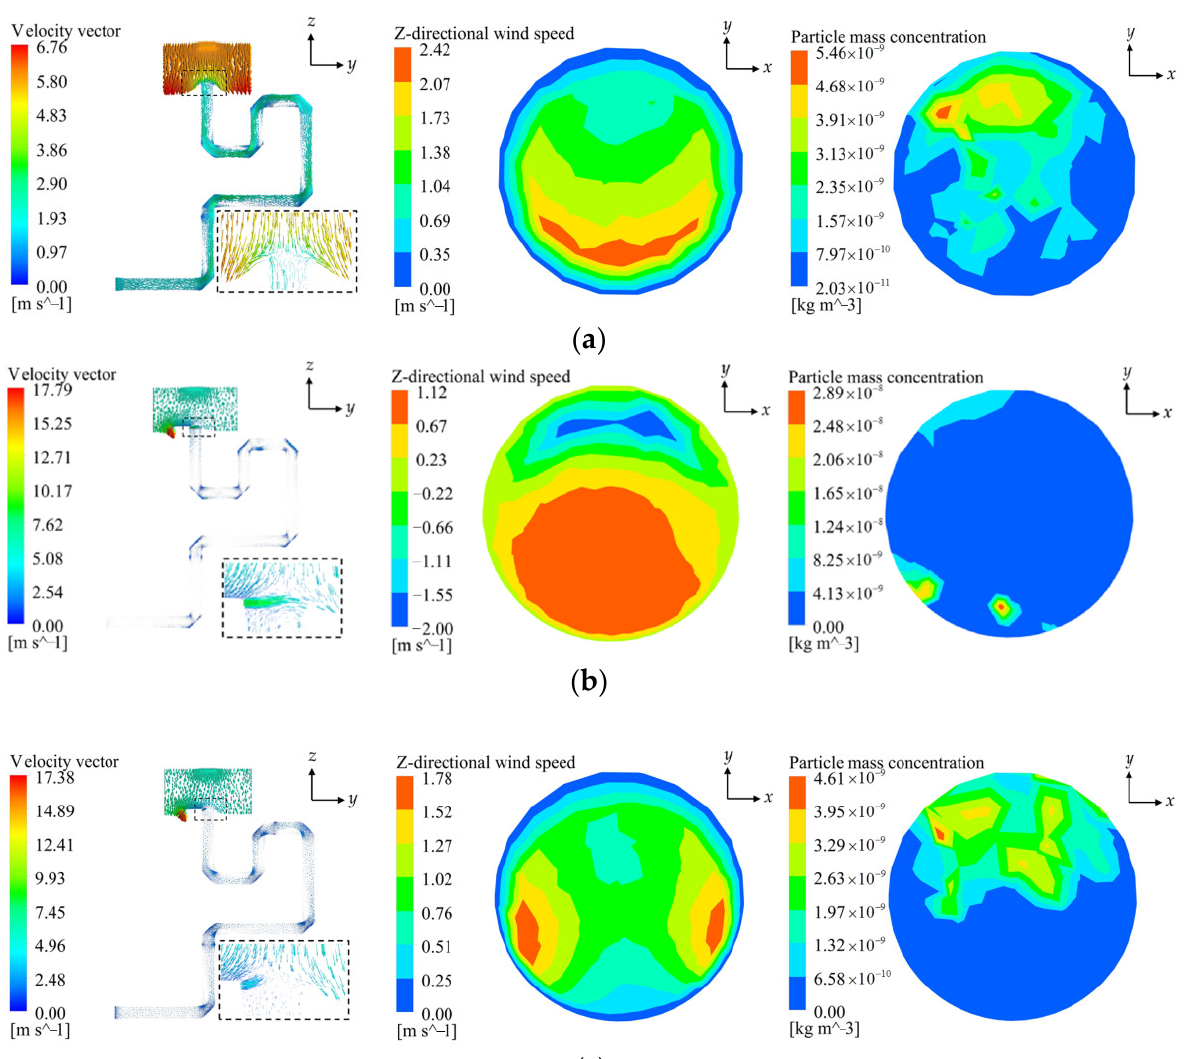
Figure 3. Velocity vector of section x = 0 mm, and the z-directional wind speed and particle mass concentration of L = 20 mm monitoring surface for the large-aperture channel under the three blowing schemes. ( a ) Axial blowing; ( b ) radial blowing; ( c ) axial–radial blowing ( l = 0 mm, v a = 1 m/s).